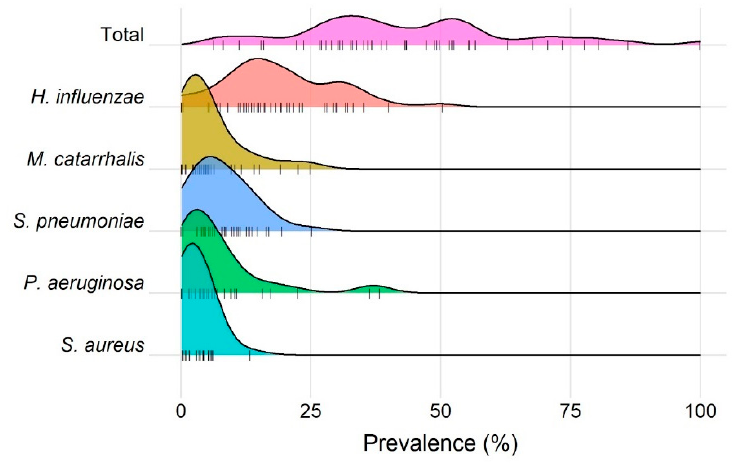
Figure 5. Ridgeline plot of the distribution of studies’ mean prevalence of potentially pathogenic microorganisms. Distributions of total prevalence, and prevalence of the top five most commonly reported organisms, are shown with each study contributing a single datapoint. Number of studies reporting each organism were: H. influenzae ( n = 36), M catarrhalis ( n = 34) , S. pneumoniae ( n = 33) , P. aeruginosa ( n = 27), and S. aureus ( n = 24).